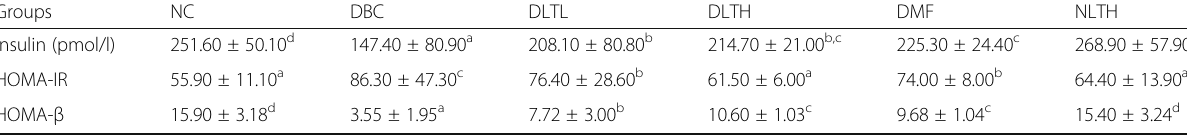
Data are shown as mean±SD. Values with different letters across the rows for a given parameter are significantly different from each other. NC normal control, DBC diabetic control, DLTL diabetic lemongrass tea low, DLTH diabetic lemongrass tea high, DMF diabetic metformin, NLTH normal lemongrass tea